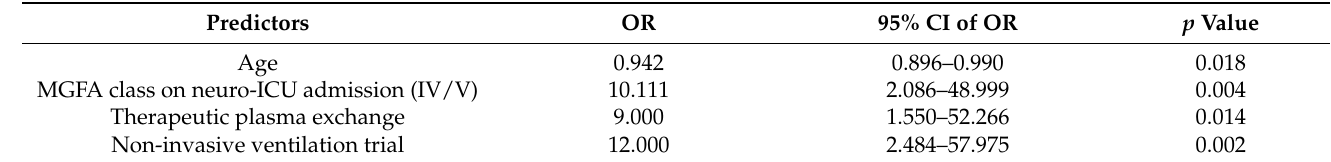
Table 4. Predictors of short-term respiratory support during MG acute exacerbations (MGFA— Myasthenia Gravis Foundation of America; ICU—intensive care